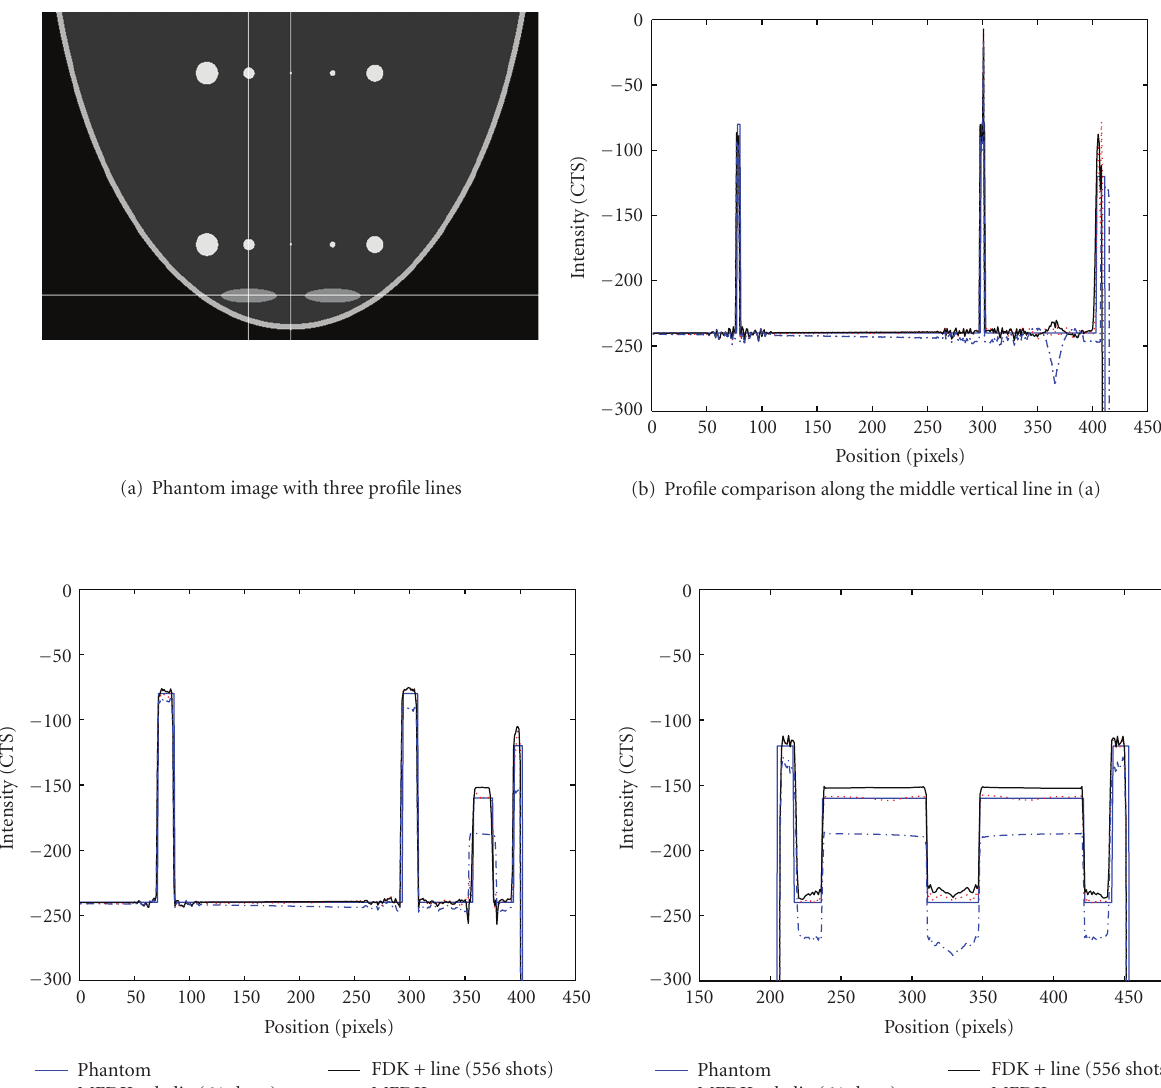
FDK + line (556 shots) MFDK (c) Profile comparison along the left vertical line in (a) (d) Profile comparison along the horizontal line in (a) Figure 9: Profile comparison between phantom, MFDK, MFDK plus helical scan, and FDK plus straight line scan schemes. (a) Phantom image with three profile lines; (b) profile comparison along the middle vertical line in (a); (c) profile comparison along the left vertical line in (a); (d) profile comparison along the horizontal line in